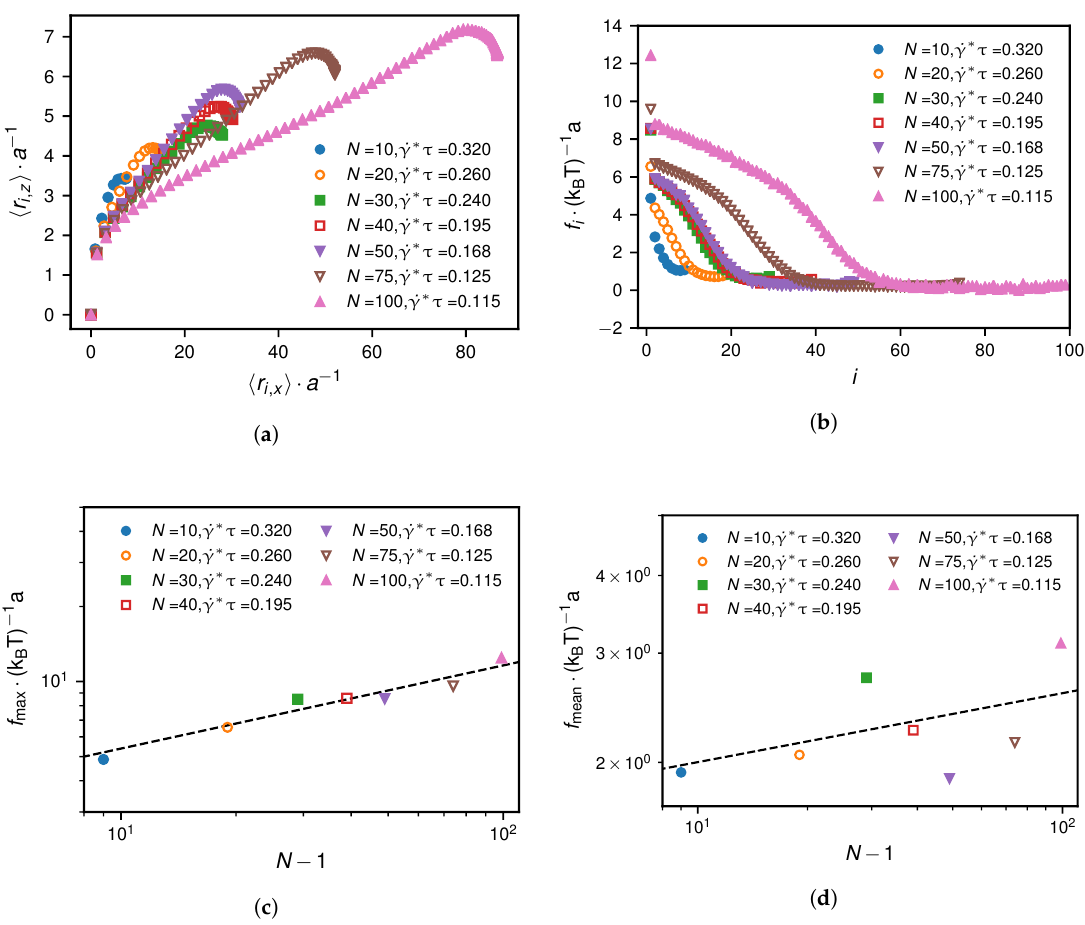
Figure 13. Grafted scenario at the critical shear rate ˙ γ ∗ : Subfigure ( a ) shows the mean monomer positions (cid:104) x (cid:105) ( i ) and (cid:104) z (cid:105) ( i ) . The resulting tensile force profiles are depicted in subfigure ( b ). Subfigures ( c , d ) show how the maximum and the mean of the tensile force profiles scale with the monomer number N − 1. The simulation results suggest heuristic scaling laws, indicated as dashed lines, which are given in Equation(24) and